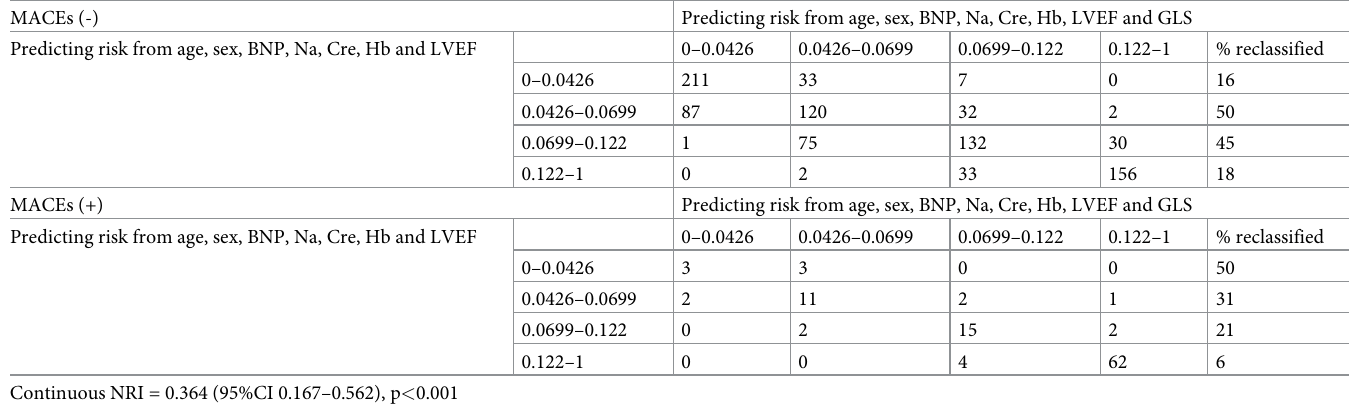
Table 5. Risk classification analysis of predicting MACEs for adding GLS to anthropometric factors and blood examination parameters. MACEs (-) Predicting risk from age, sex, BNP, Na, Cre, Hb, LVEF and GLS Predicting risk from age, sex, BNP, Na, Cre, Hb and LVEF